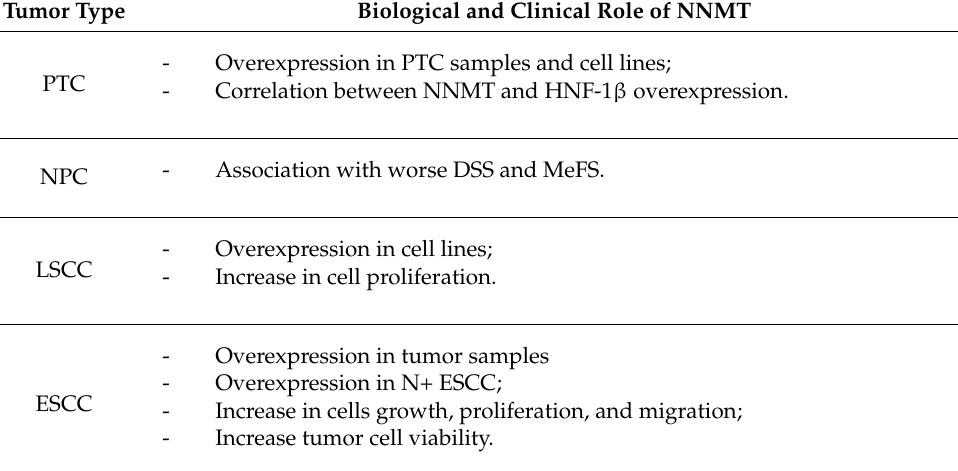
Table 2. Cont . Tumor Type Biological and Clinical Role of NNMT - Overexpression in PTC samples and cell lines; PTC - Correlation between NNMT and HNF-1 β overexpression.